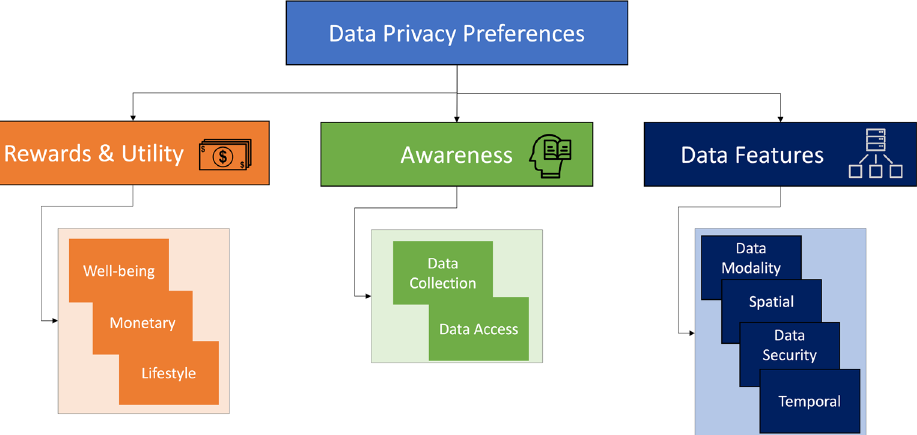
Figure 2. Interview responses were analyzed and categorized with codes. The initial codes were pooled from the separate coding of three researchers and refined through discussion and iterative analysis of the transcripts. The individual codes formed three categories – Rewards & Utility, User Knowledge, and Data Features – that fall under a larger umbrella of data privacy preferences.